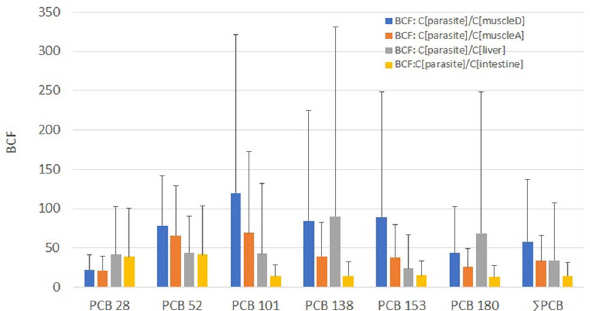
Figure 4. Ratios of PCB concentrations (bioconcentration factors—BCFs) (mean ± SD) (ng g −1 of w.w.) in G. osculata relative to that in fish matrices. MuscleD —dorsal muscle, MuscleA —abdominal